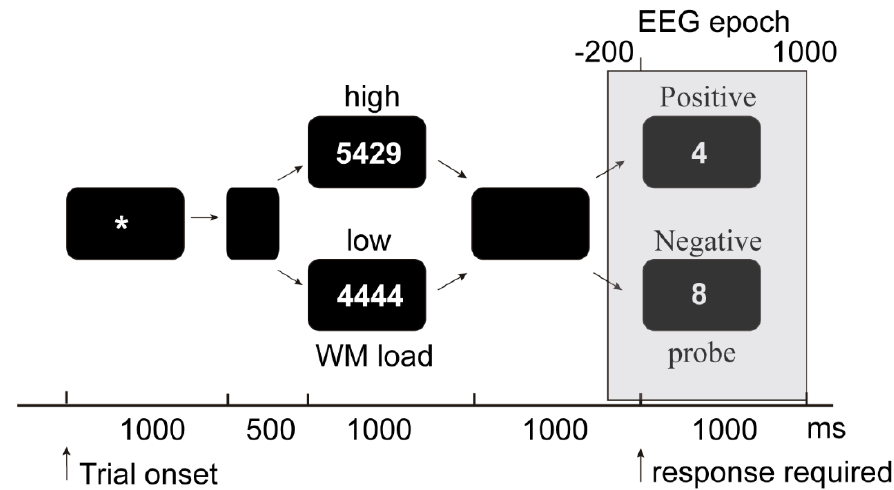
Figure 1. Flowchart of the Sternberg working memory (WM) task. Examples of memory sets and probes for the high and low WM load conditions that either do or do not belong to the set (positive and negative probes, respectively). The gray box represents a time-locked window of the continuous EEG.